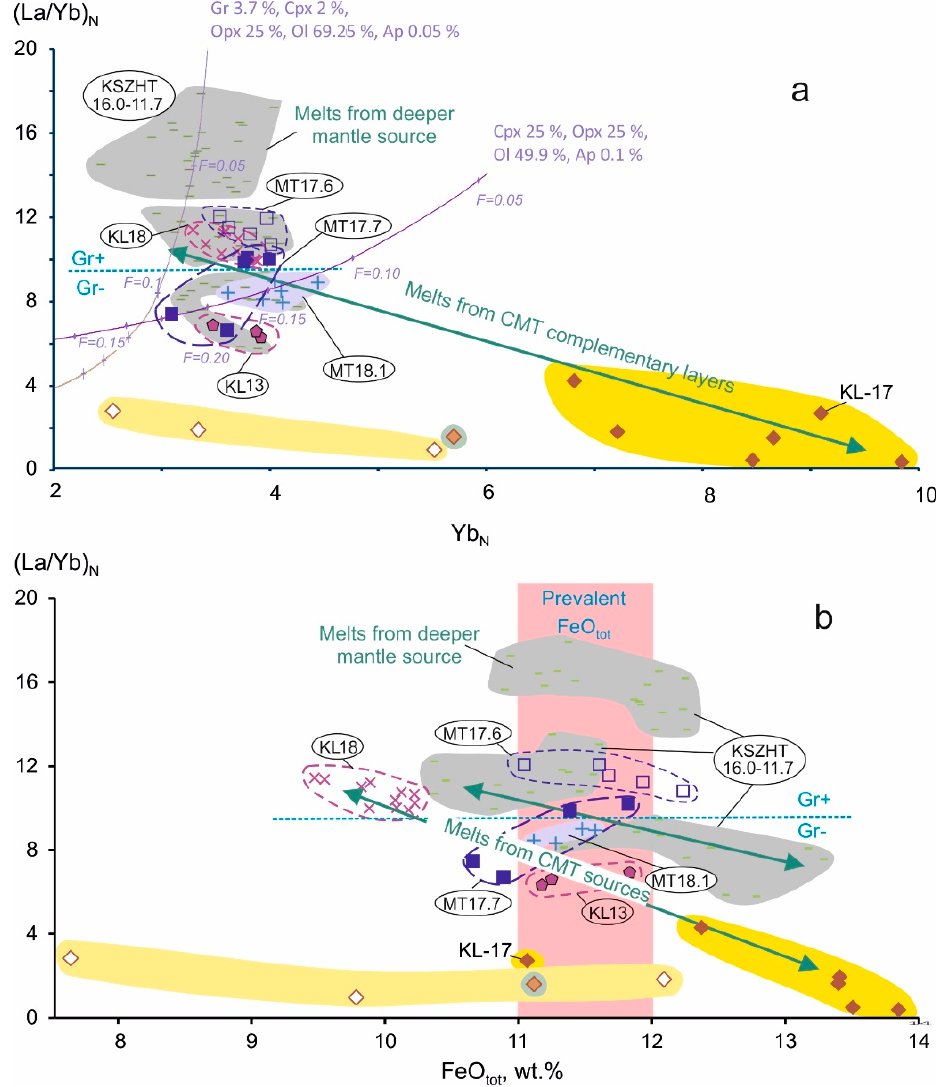
Figure 10. Cont. Figure 10.